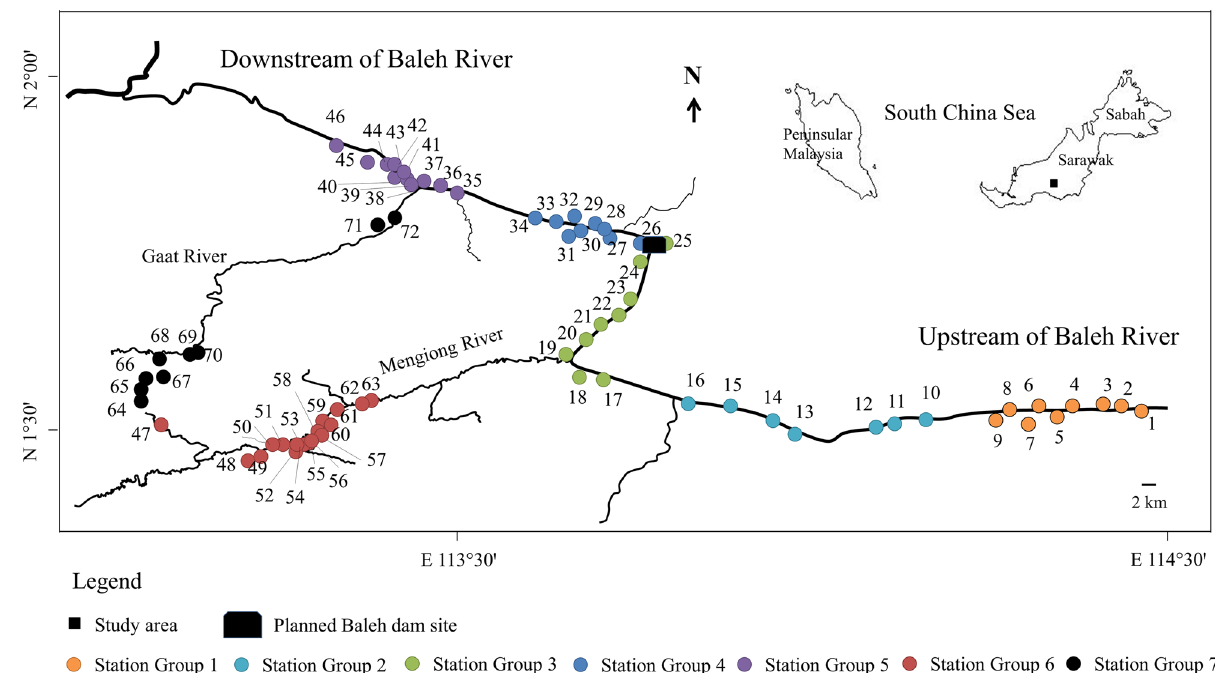
Figure 1. The location of the seven groups with a total of 72 sampling stations at the Baleh River Basin, Kapit,